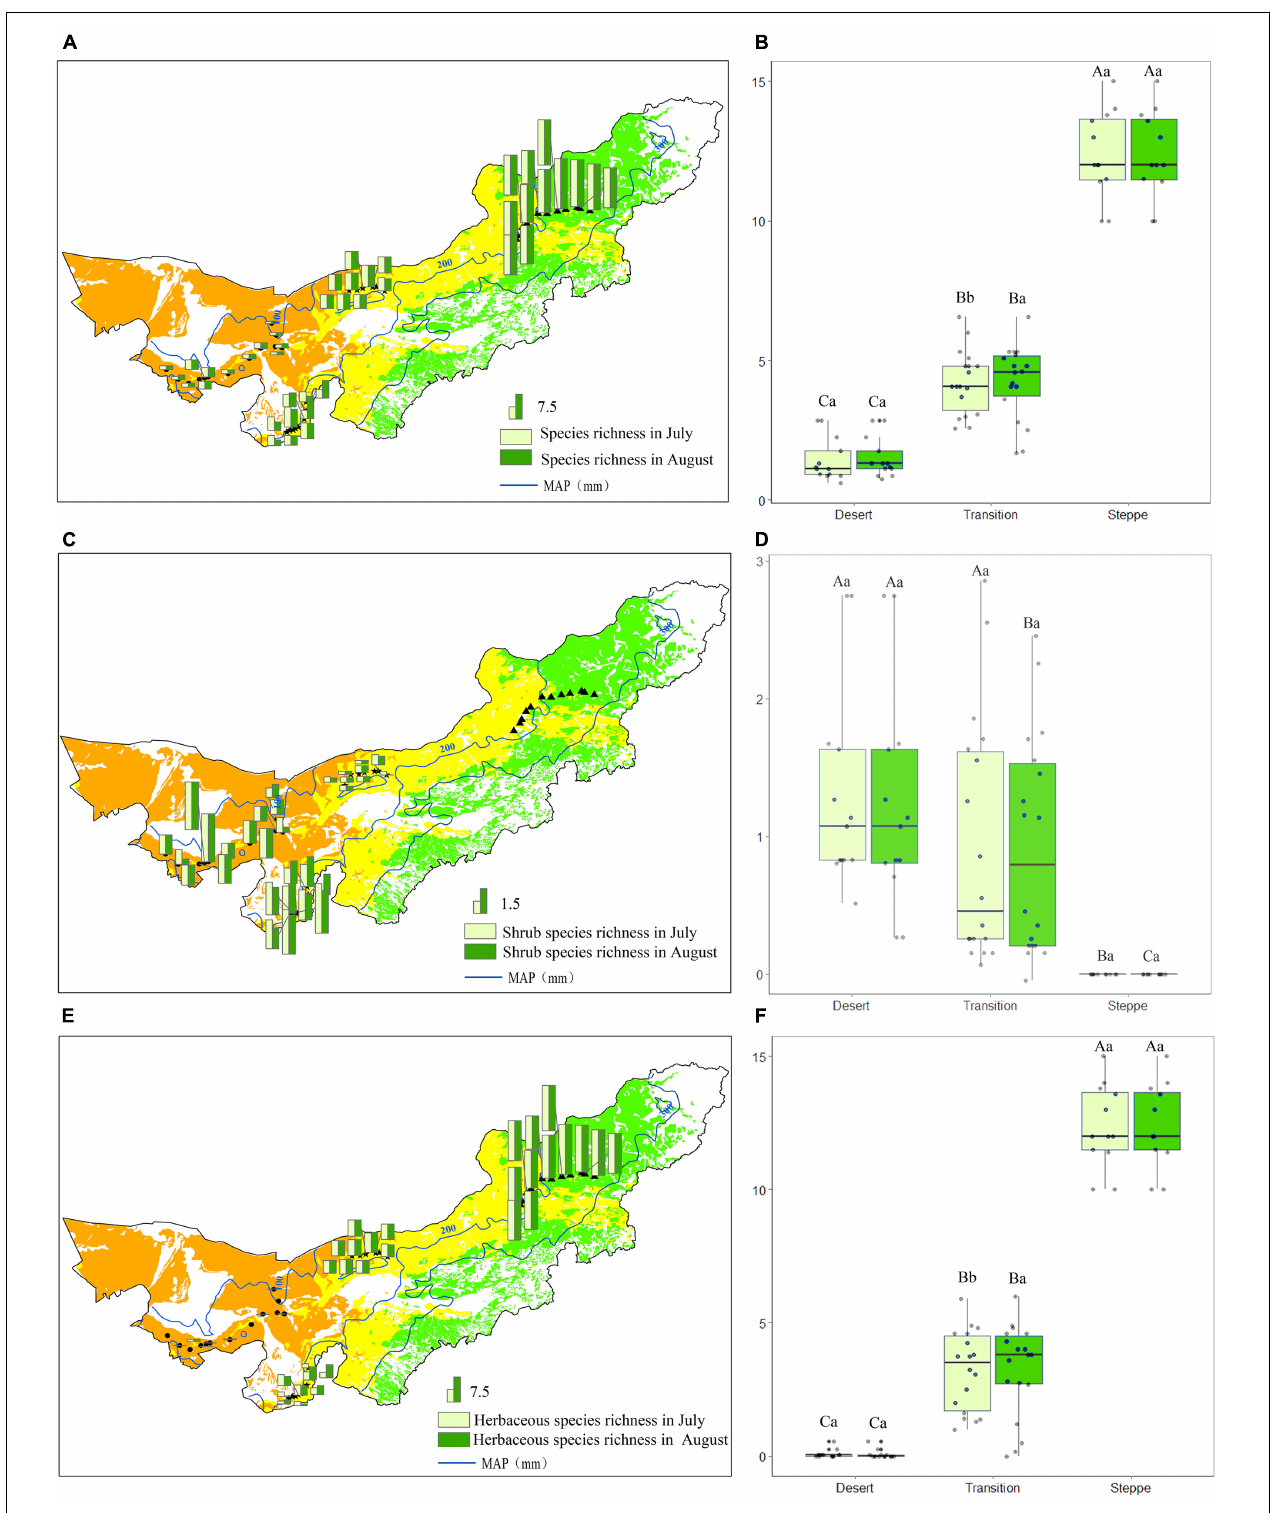
FIGURE 7 | Species richness (A,B) , shrub species richness (C,D) and herbaceous species richness (E,F) in each observation site (A,C,E) , and statistics for desert, transition zone, typical steppe (B,D,F) . Different capital letters denoted significant differences of species richness among desert, transition zone, and typical steppe ( P < 0.05); while different lowercase letters denoted significant differences between July and August ( P < 0.05); the same letters denoted non-significant differences ( P > 0.05); MAP represents the mean annual precipitation.